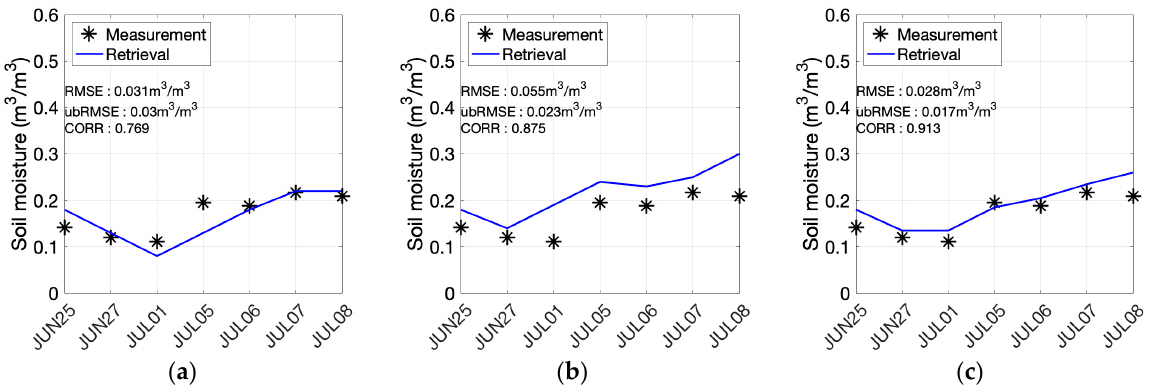
Figure 7. Soil moisture retrieval at corn site 6 from ( a ) L-band ( b ) S-band ( c ) combined L- and S-